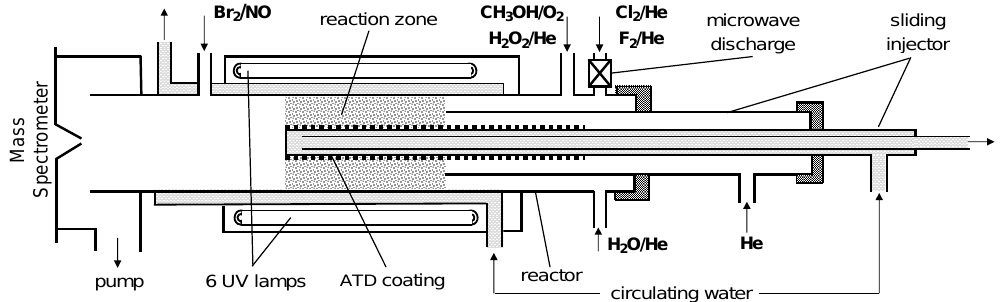
Fig. 1. Diagram of the flow